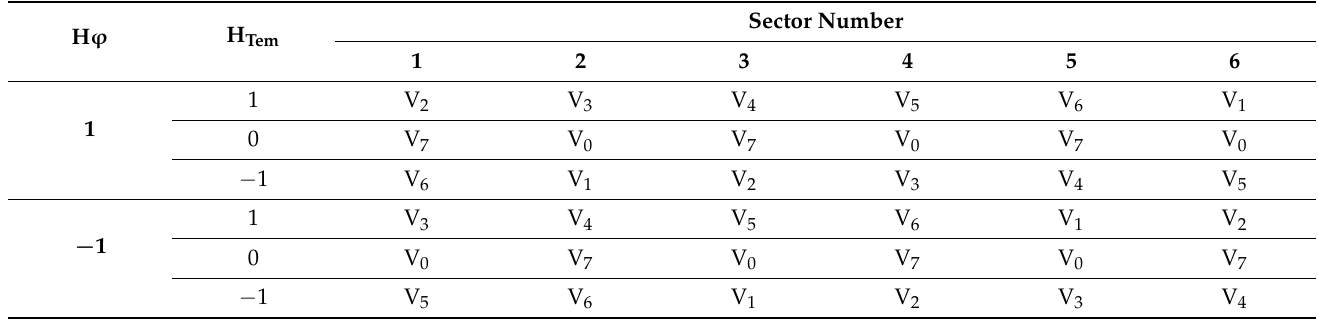
Figure 13. Voltage vectors in the 6-sectors DTC. Table 1. Switching Table of the 6-sectors